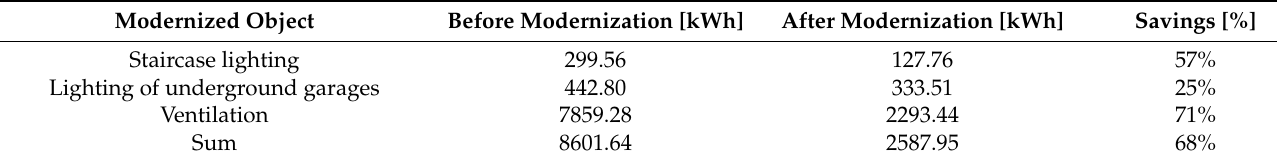
Table 5. Proposed energy savings.